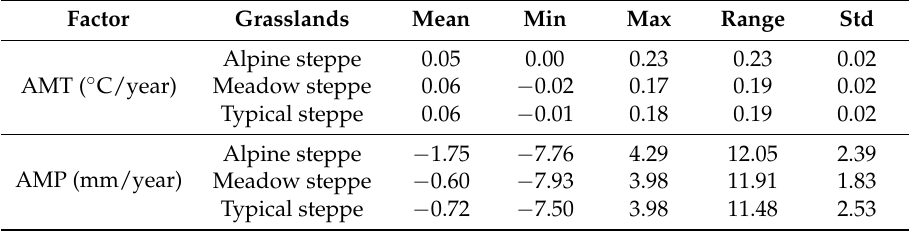
Table 2. The variation of climatic factors (annual mean temperature [AMT] and annual mean precipitation [AMP]) in three grasslands (1985–2010). The Mean, Min, Max. and Std are the average, minimum, maximum, and standard deviation values, respectively, of the AMT or AMP in corresponding grasslands from 1985 to